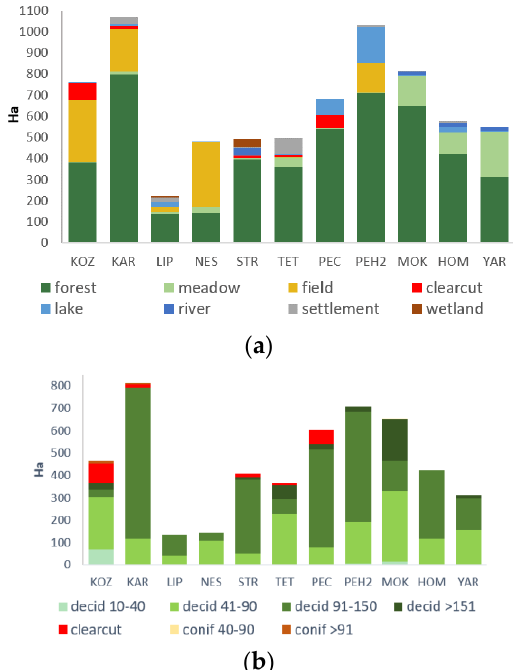
Figure 2. ( a ) Areas of originally distinguished land cover types in study plots (for abbreviations of study plots, see Table 1). ( b ) Areas of originally distinguished forest types and ages in study plots (for abbreviations of study plots, see Table 1): clearcut—clear cuttings; conif—coniferous